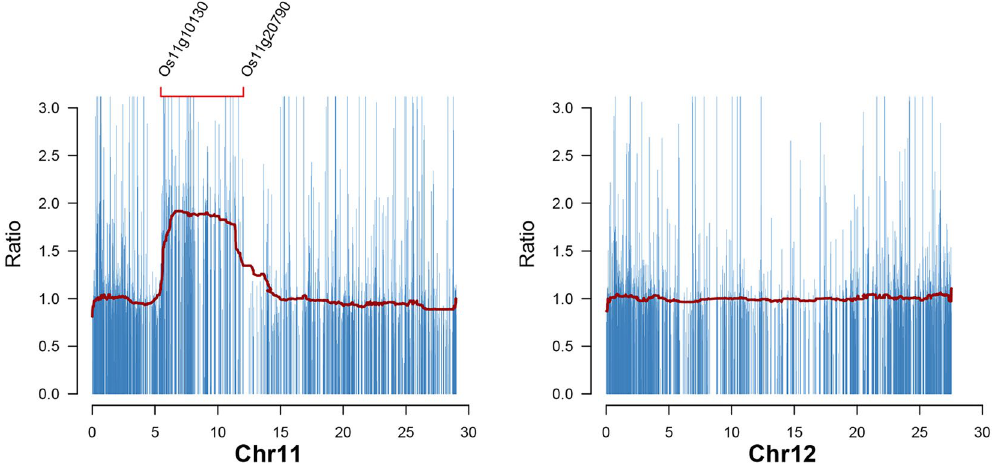
Figure 6. Gene expression level between Chr11 and Chr12 in YZG-5. Blue bar represents expression level change of each expressed gene (FPKM > 0) in Chr11 and Chr12 of YZG-5. Red lines represent median score of expression level change in 100 genes sliding windows. X-axis represent genes loci. The region from Os11g10130 to Os11g20790 represents 11S-2.